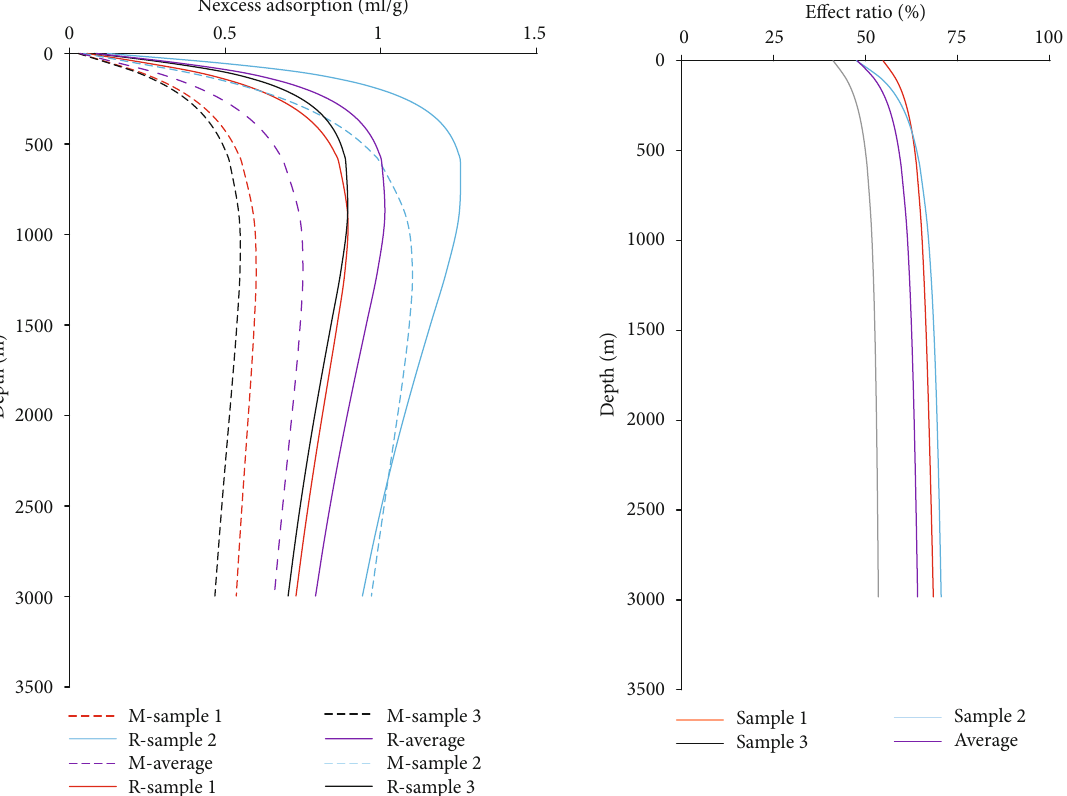
Figure 10: The adsorption amount of mineral composition and its contribution to the total adsorption amount changing with depth in shale.